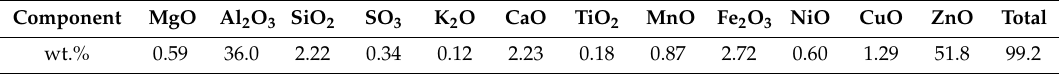
Table 2. Major chemical composition of electric arc furnace (EAF) dust.